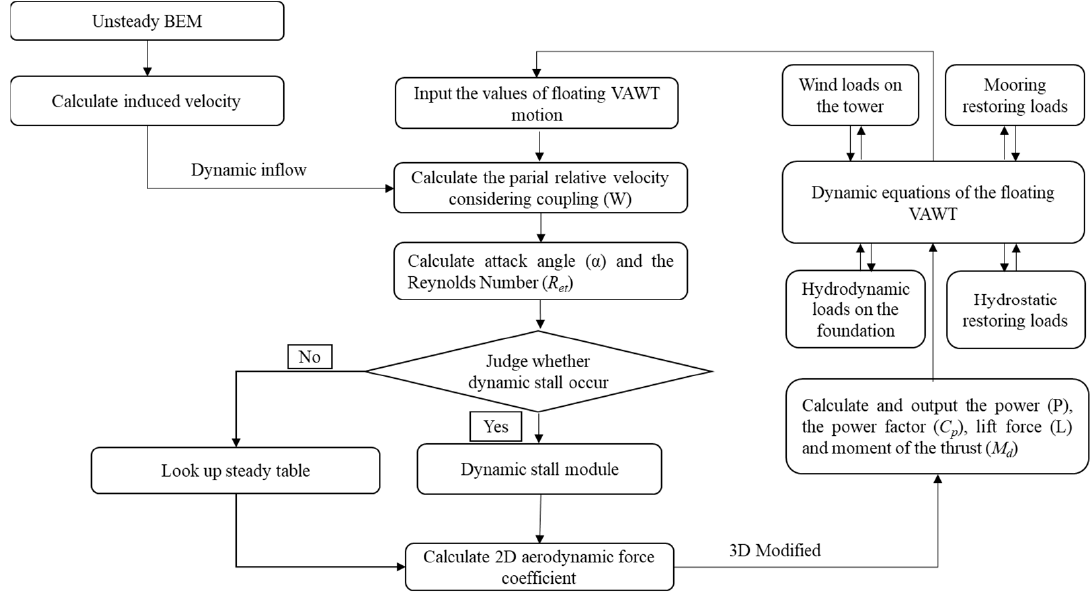
Figure 5. Flow chart of HeVAWT.